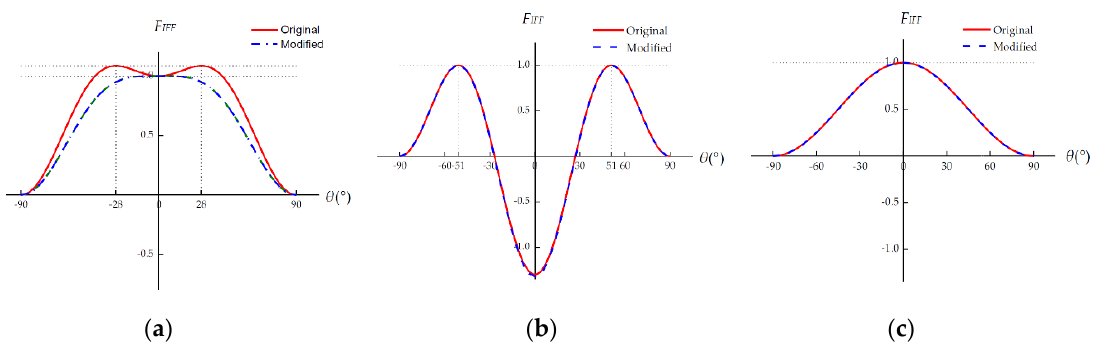
Figure 6. F IFF – θ relation under simple stress states for the ply embedded in a multidirectional laminate. ( a ) σ 2 = Y is ; ( b ) σ 2 = − Y is ; ( c ) τ 21 = S is .